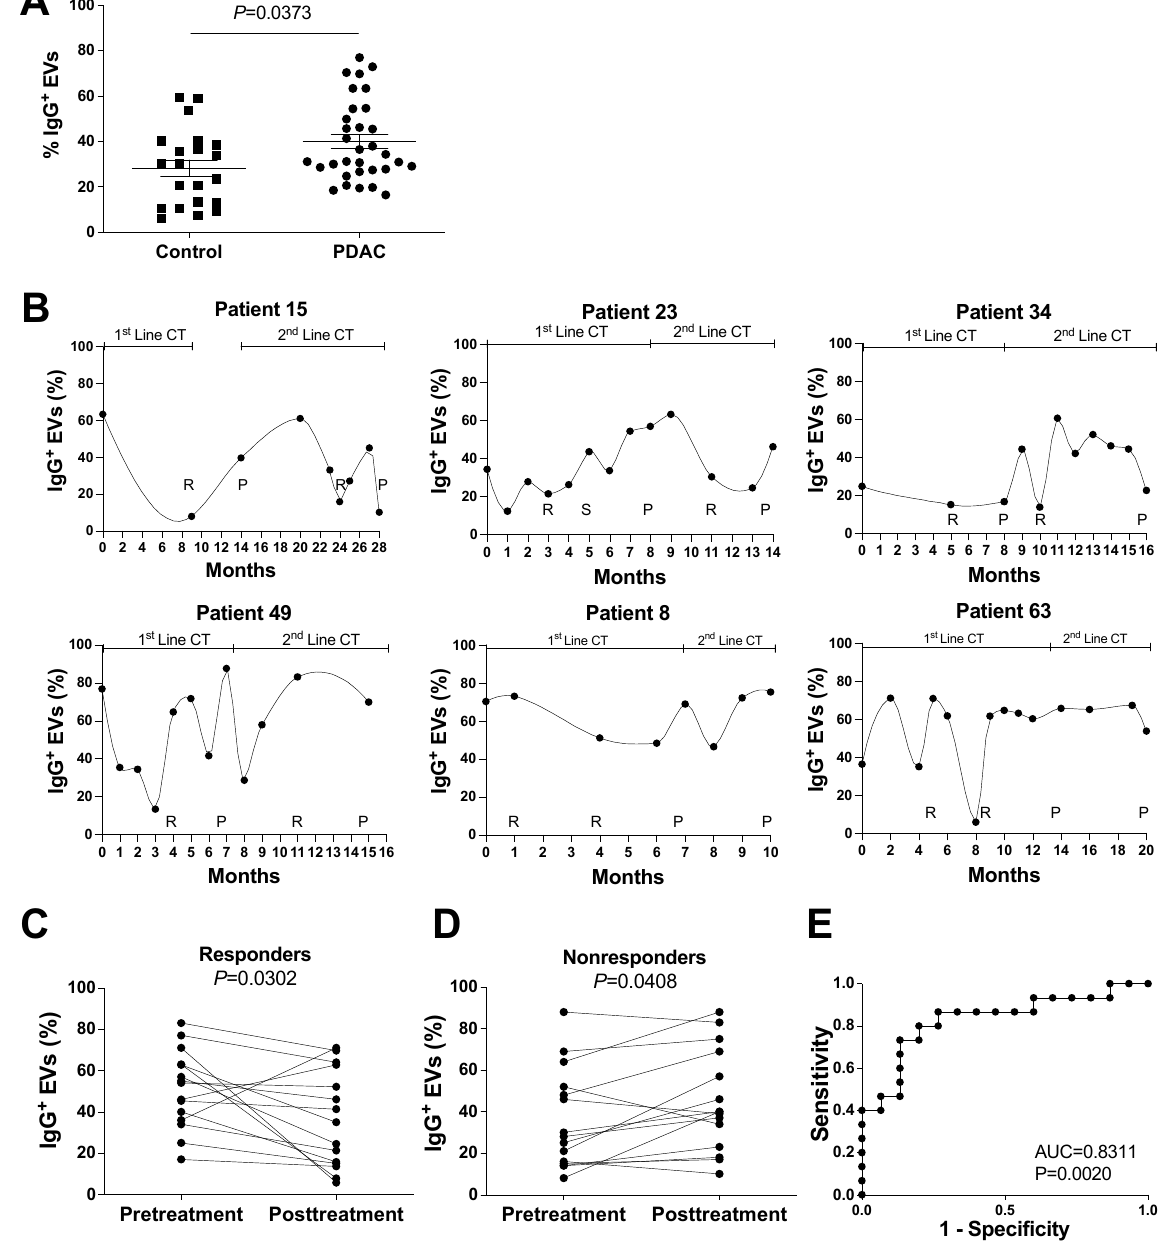
Figure 4. IgG+ EVs in healthy controls and PDAC patients. Vesicle flow cytometry data of plasma samples from PDAC patients and healthy controls, as indicated. ( A ). Comparison of IgG+ EVs between PDAC patients and healthy controls, p = 0.037, by Wilcoxon test. ( B , C ). Longitudinal evaluation of plasma IgG+ EVs in patients followed during at least 2 lines of chemotherapy (mFOLFIRINOX in the 1st line, and Gemcitabine with Nabpaclitaxel in the 2nd line, as indicated), that express CA19.9 ( B ) patients 15, 23, 34, and 49; or do not express CA19.9 ( C ) patients 8 and 63. The moments of imagiological evaluation are indicated (R for response, S for stabilization, and p for progression to chemotherapy). ( C , D ). Evolution of IgG+ EVs before and after treatment with chemotherapy in 15 situations of response ( C ) and no response ( D ) to treatment. p = 0.039 ( C ) and p = 0.037 ( D ), by t-test. ( E ) ROC curve for the IgG+ EV to discriminate response in patients with metastatic PDAC. Data were obtained from patients 15, 23, 34, 49, 63, 69, 70, 73, and 94 ( D ); and patients 8, 10, 15, 21, 22, 23, 34, 49, 66, and 73 ( E ).